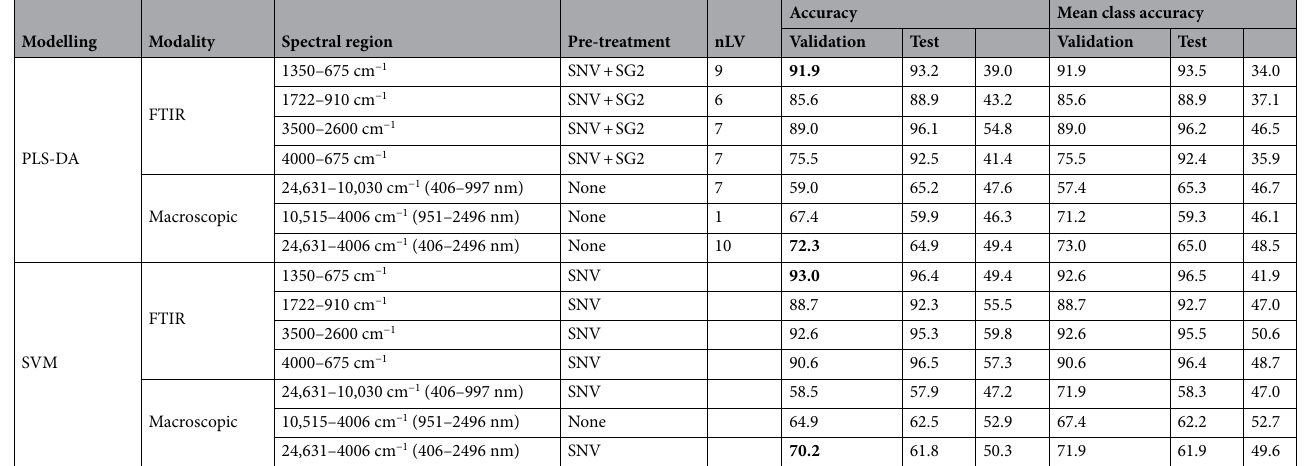
Table 5. Model performances for discrimination between gram-positive BS and LP based on pixel spectra. For each modality/spectral region, the model yielding maximum accuracy in the validation set is